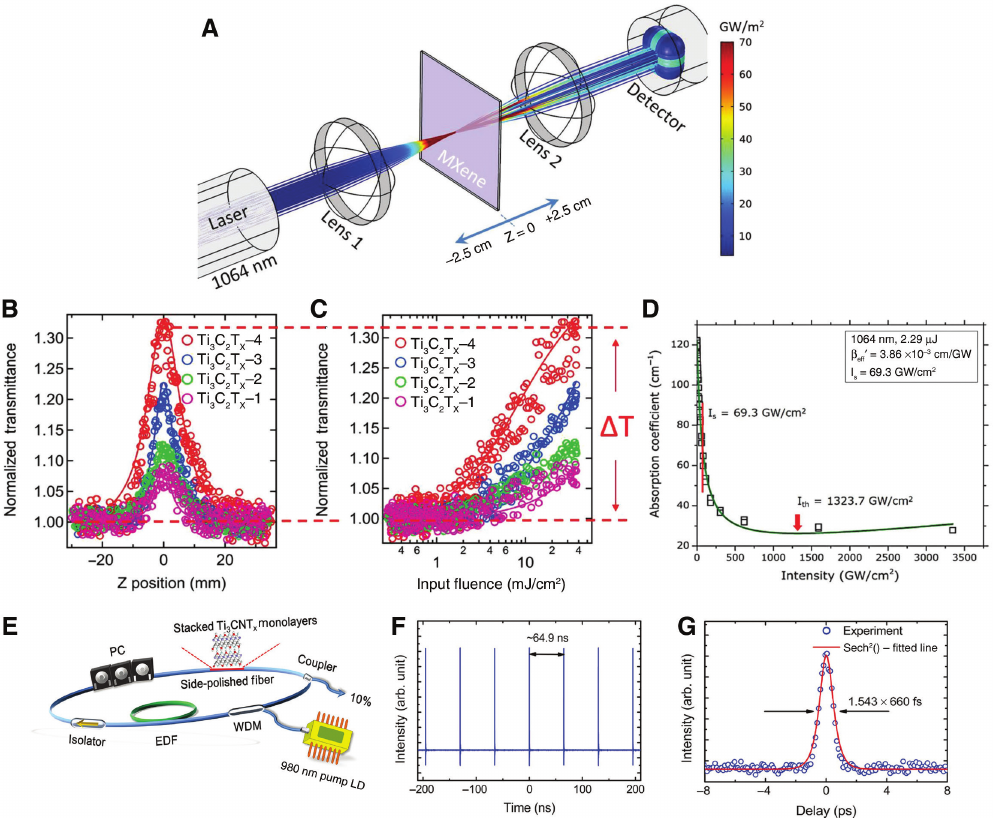
Figure 8: Selected nonlinear optical properties. (A) Illustration of an MXene thin film Z-scan measurement experiment. (B and C) Saturable absorption property of Ti is tested. (D) Relationship between absorption coefficient and laser intensity of MXene at 1064 nm. (E) Illustration of a Ti mode-locker implemented ring-cavity erbium-doped fiber laser. (F) This can generate femtosecond laser pulses. (G) Autocorrelation trace measured in (E). (A–C) Adapted with permission from [95]. (D) Adapted with permission from [17]. (E–G) Adapted with permission from [96], Wiley-VCH Verlag GmbH & Co. KGaA,